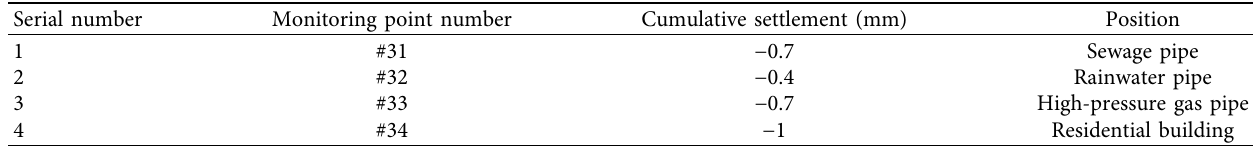
Figure 22: Vertical settlement duration curve of pile foundation. Table 2: Summary table of vertical accumulated settlement at key locations.